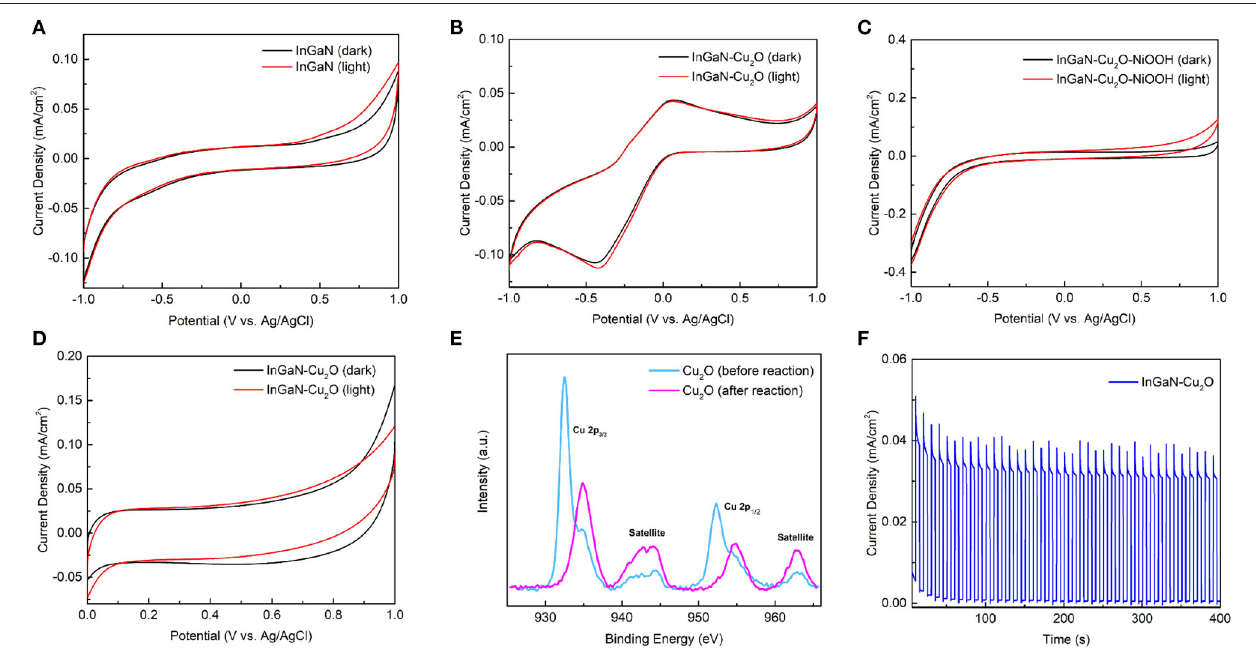
FIGURE 6 | Cyclic voltammetry (CV) curves taken in the dark and under illumination of the (A) bare InGaN NWs, (B) InGaN/Cu 2 O core-shell NWs, (C) InGaN/Cu 2 O/NiOOH complete photoanode, and (D) InGaN/Cu 2 O core-shell NWs. (E) XPS spectra taken from the InGaN/Cu 2 O core-shell NWs before and after the water splitting experiment. (F) I–t measurement at + 0.6V vs. Ag/AgCl (1.2V vs. RHE) for the InGaN/Cu 2 O core-shell NWs under chopped